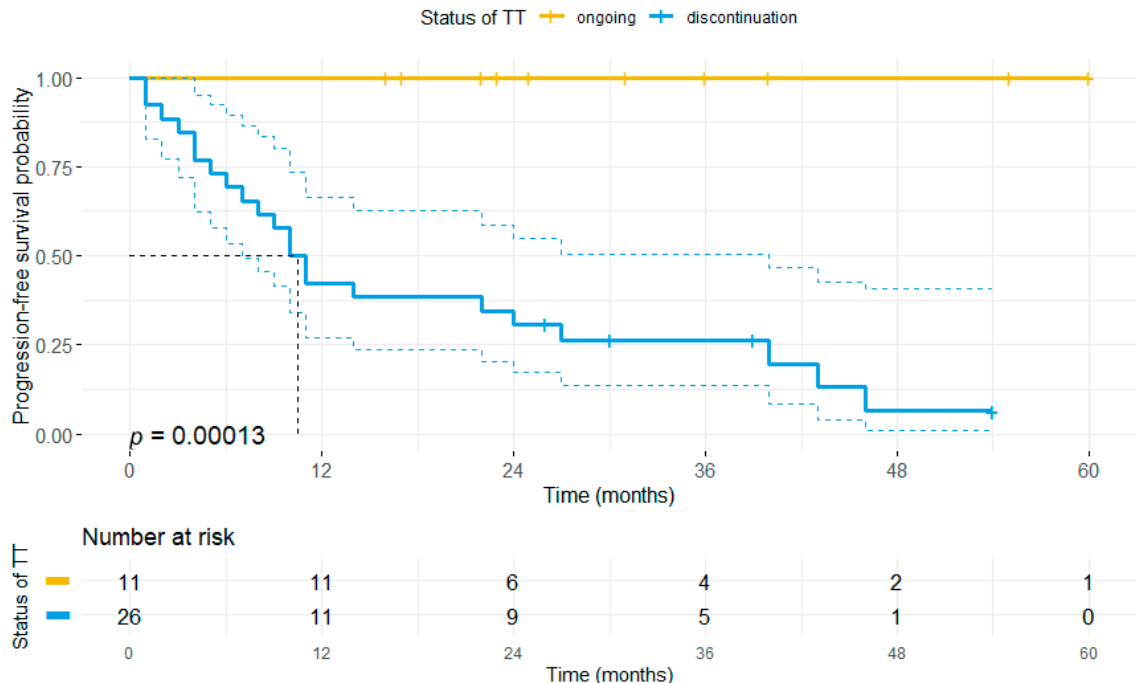
Figure 4. Discontinuation of TT correlates with the risk of disease progression. All patients who obtained CR upon BRAF ± MEKi treatment and received therapy until data cut-off (n = 11) maintained their CR, whereas 22 of 26 patients who discontinued BRAF ± MEKi therapy at any time point during the observation period eventually relapsed. Accordingly, patients who had terminated TT showed a significantly shorter PFS (median: 10 months) compared to patients with ongoing BRAF ± MEKi therapy. Notably, patients who maintained their CR until treatment cessation showed a lower risk of tumor relapse after treatment cessation (n = 3/7) as compared to all patients ceasing TT.